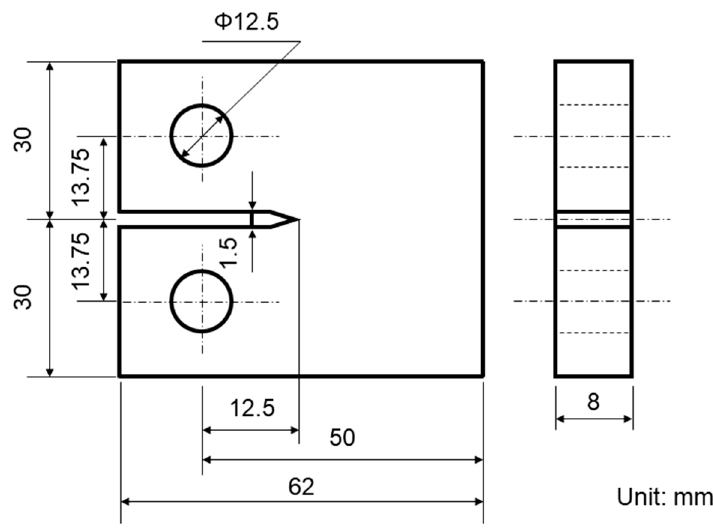
Figure 4. Sample dimensions for testing the fatigue crack propagation